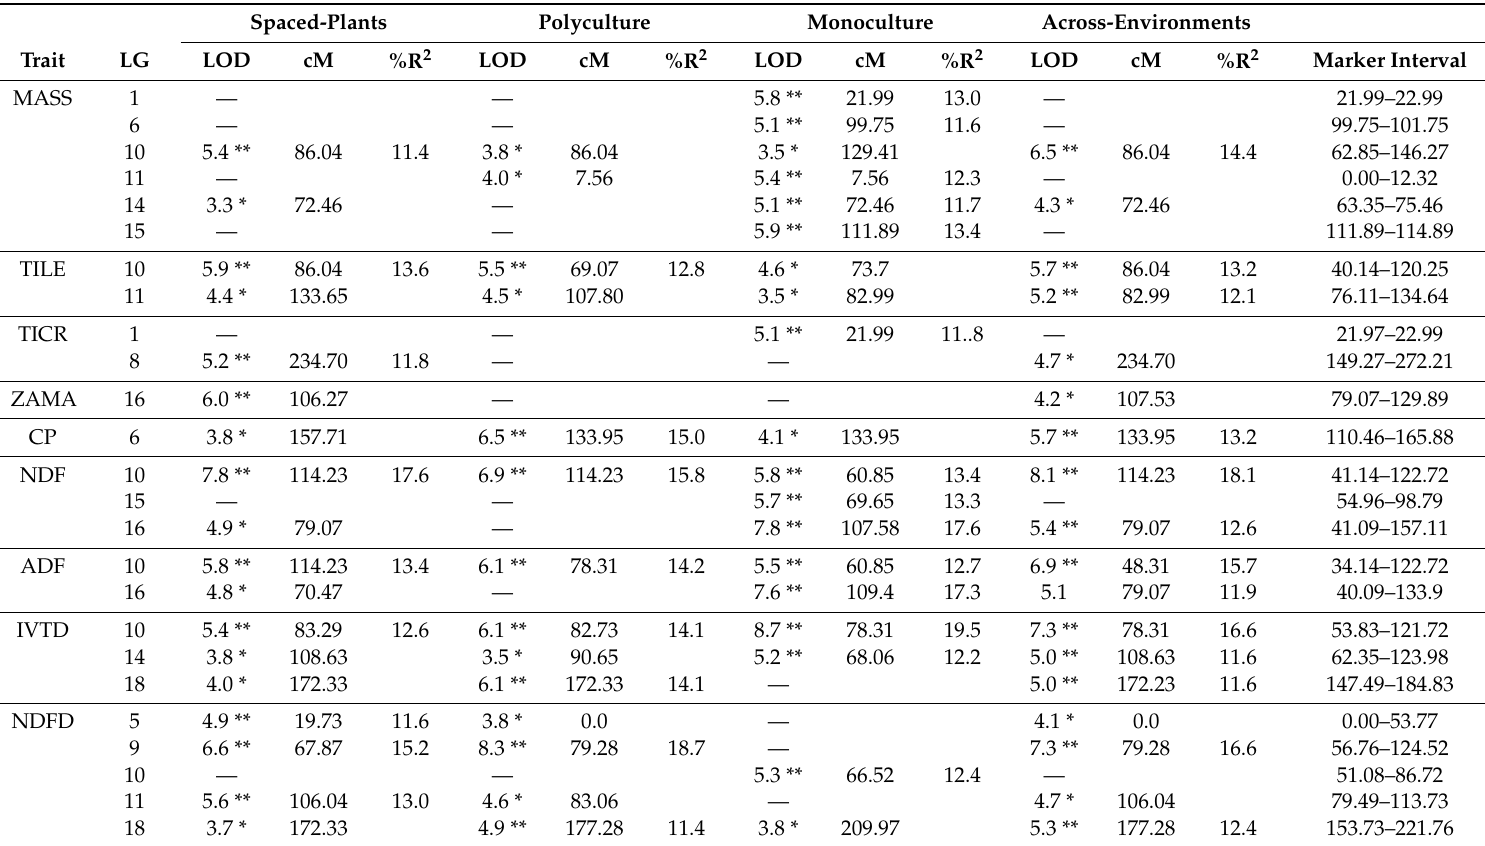
Table 4. QTL identified for 192 clonally replicated, full-sib progeny (genets) of the M26 × M35 intermediate wheatgrass mapping population evaluated over two years (2016–2017) in three competition environments (spaced-plants, polyculture, and monoculture) at Logan, UT, USA. Only QTL with genome-wide significance in at least one environment are listed. The linkage group (LG), most significant marker LOD value, chromosomal position (cM), and percent variation explained (%R 2 ) (only for genome-wide significance), and overall marker interval are